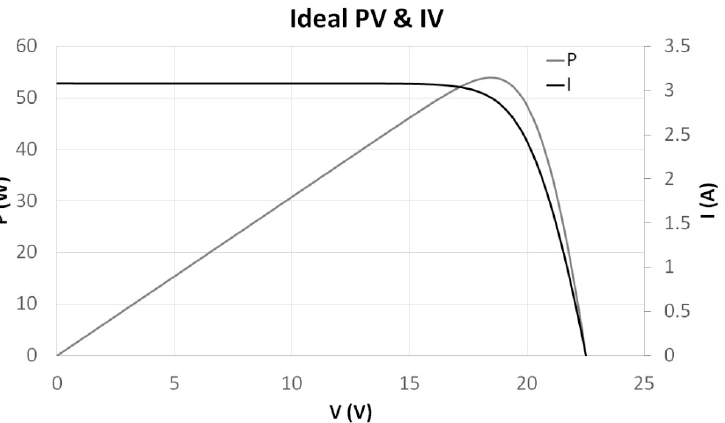
Figure 6. IV and PV curves of a panel simulated in Matlab with the same I SC and V OC of the measured panel, and good recombination characteristics (R S = 0.8 Ω ·cm 2 ; R P = 97.34 k Ω ·cm 2 ; J 01 = 1.5·×·10 − 12 A/cm 2 ; J 02 = 1.5·×·10 − 8 A/cm 2 ).